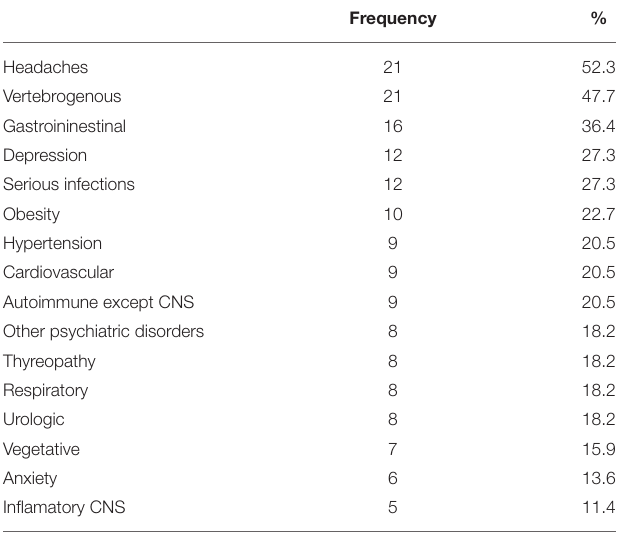
TABLE 2 | Frequency of more common disorders and diseases potentially related to hypersomnias within the